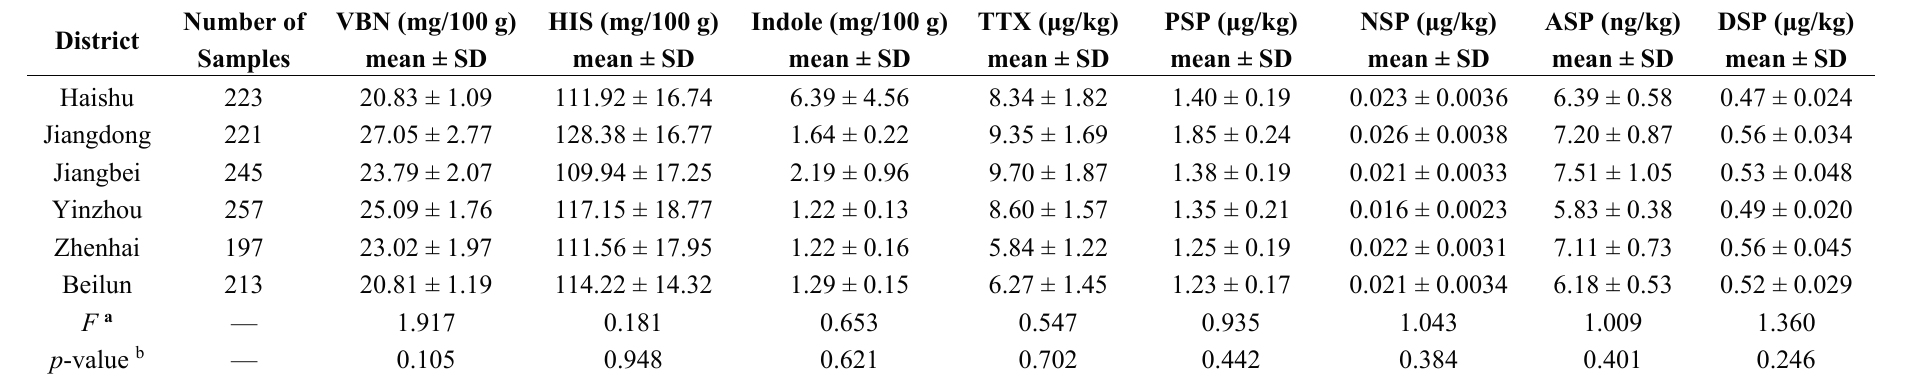
Table 2. Location distribution of the different hygiene index values of live fresh aquatic products among six districts.